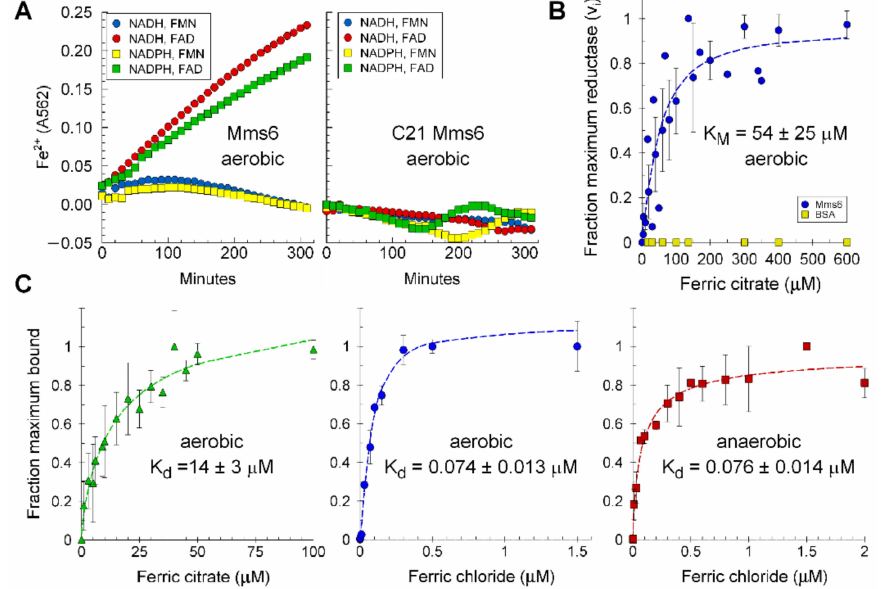
Figure 2. Mms6 ferric reductase specificity for cofactor and electron donor: ( A ) Mms6 (left) and C21Mms6 (right) were tested with 100 µ M NADH or NADPH as electron donors combined with either 100 µ M FAD or FMN as cofactors in 20 mM Tris, 100 mM KCl, 1 mM ferrozine, and 100 mM ferric citrate, pH 7.5. Reaction mixes run in parallel without protein were used as the background to subtract from the results of incubation with 20 µ M Mms6 with the combinations of cofactor and electron donor shown; ( B ) reductase activity (initial velocity) was determined at a range of Fe 3+ -citrate concentrations to determine the K M ± standard error for the reductase. Shown is the compiled data from 9 independent experiments involving 6 different protein preparations (r 2 = 0.80, error of the estimate = 0.16); ( C ) the K d of Mms6 was determined under aerobic conditions at pH 7.5 and pH 7 for ferric citrate and ferric chloride, respectively, and anaerobic conditions at pH 7 for ferric chloride. The ferric citrate binding isotherm was created from the averaged results of 11 independent experiments (duplicates per experiment) with 2 assessed by intrinsic fluorescence and the remainder by 55 Fe binding with filter capture. In total, 5 different protein preparations were tested. The aerobic and anaerobic ferric chloride binding isotherms are each the average of two independent experiments with one (anaerobic) or two (aerobic) protein preparations and assessed by 55 Fe binding with filter capture. On each plot, the estimated K d ± standard error is shown. Goodness of fit: Fe-citrate, aerobic (r 2 = 0.97, error of the estimate = 0.061), FeCl 3 , aerobic (r 2 = 0.99, error of the estimate = 0.057), and FeCl 3 , anaerobic (r 2 = 0.98, error of the estimate =